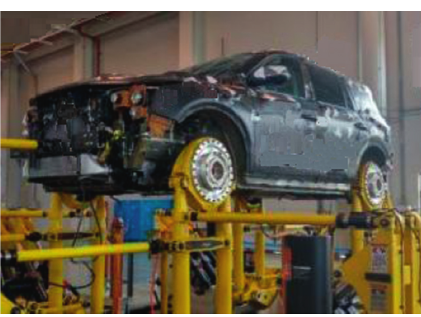
Figure 3: Bench test.